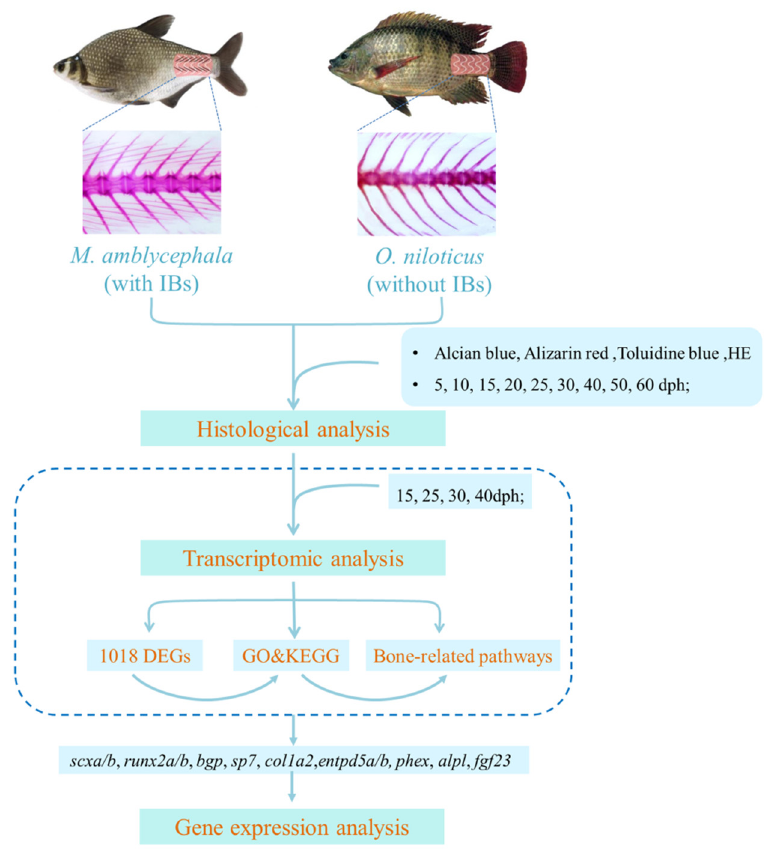
Figure 1. Research scheme diagram.